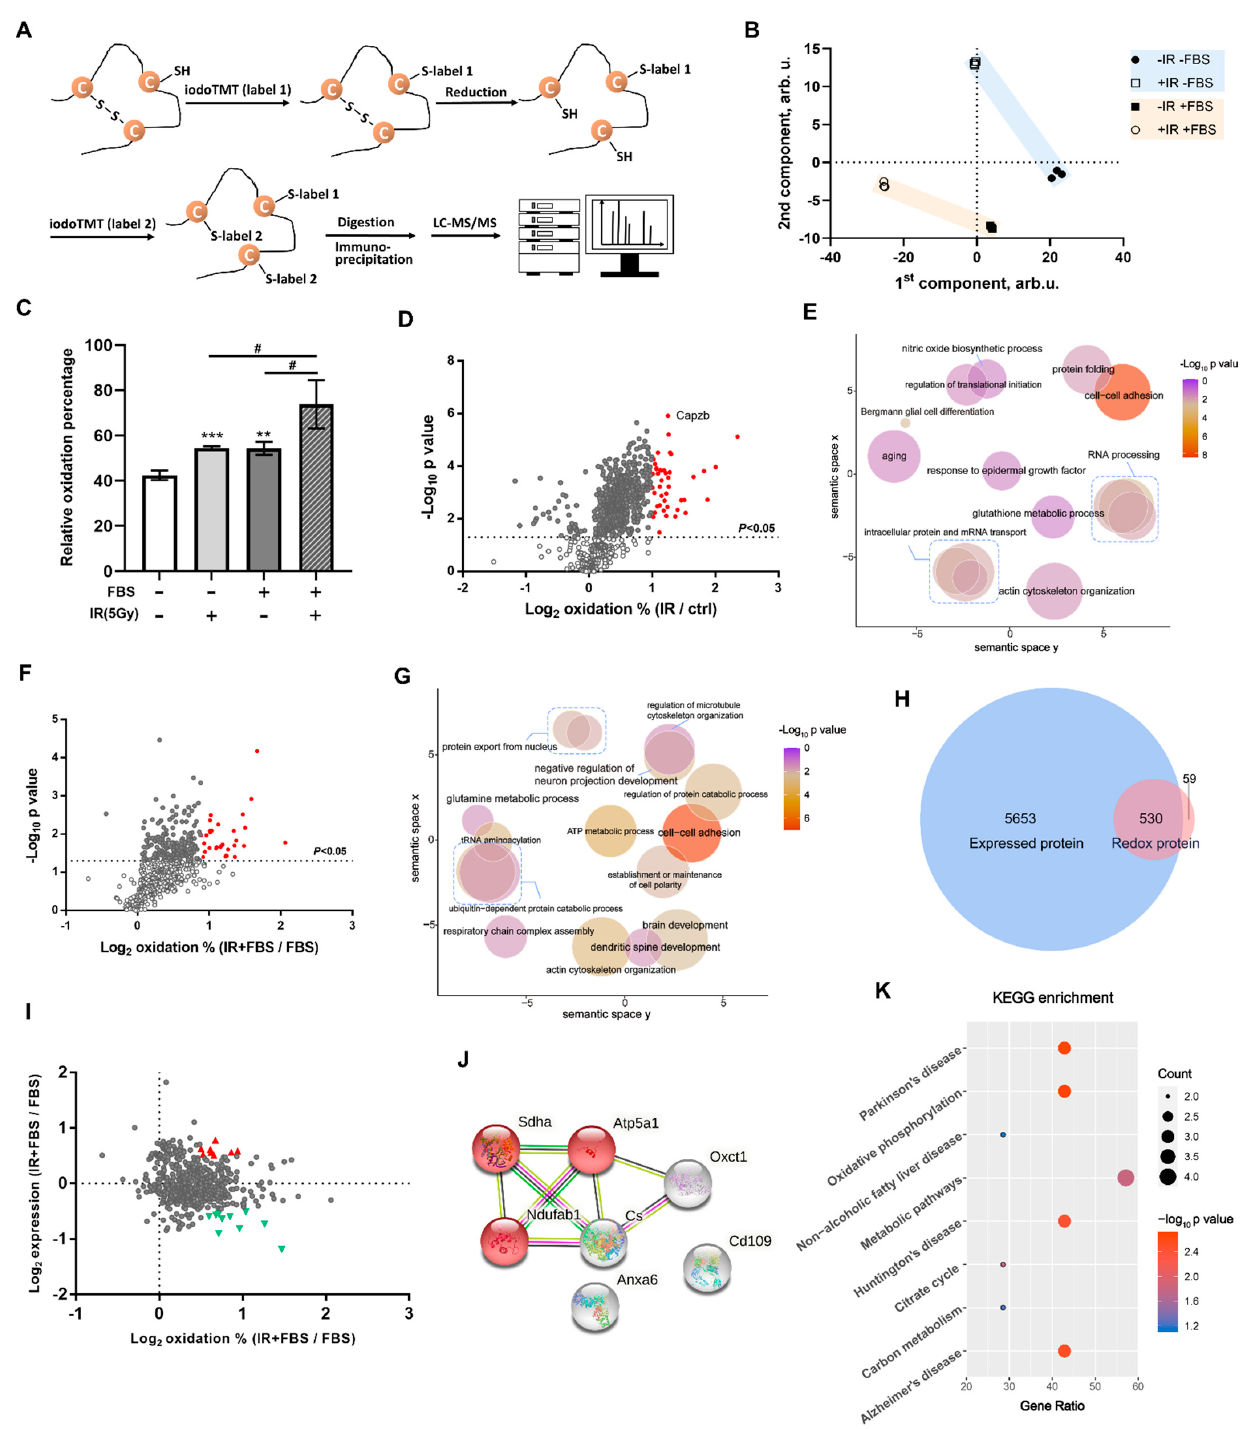
Figure 5. Redox protein detection and expression-oxidation conjoint analysis. ( A ) Schematic depiction of disulfide bond reduction workflow and free thiol-labeled oxidation proteomic screening. ( B ) Principal component analysis (PCA) of proteomic oxidation profile among groups, “－ FBS － IR ” represents the “ ctrl ” group, “－ FBS+IR ” denotes the “ 5Gy_ctrl ” group, “ +FBS － IR ” represents the “ FBS_ctrl ” group, and “ +FBS+IR ” represents the “ 5Gy+FBS_ctrl ” group. ( C ) Bar Graph show- ing the relative oxidation percentage of proteome-wide sulfhydryl groups among different treat- ment groups; data were represented as Mean ± SEM; n = 3; ** p < 0.01, *** p < 0.001 as compared with